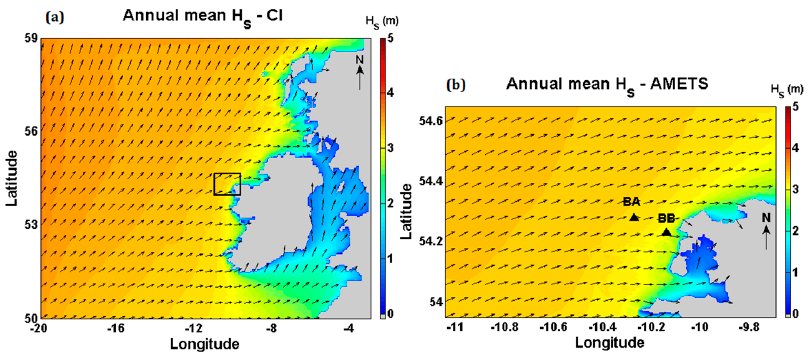
Figure 5. 12-year annual means of H s (m) and MWD for ( a ) CI model and ( b ) AMETS model.